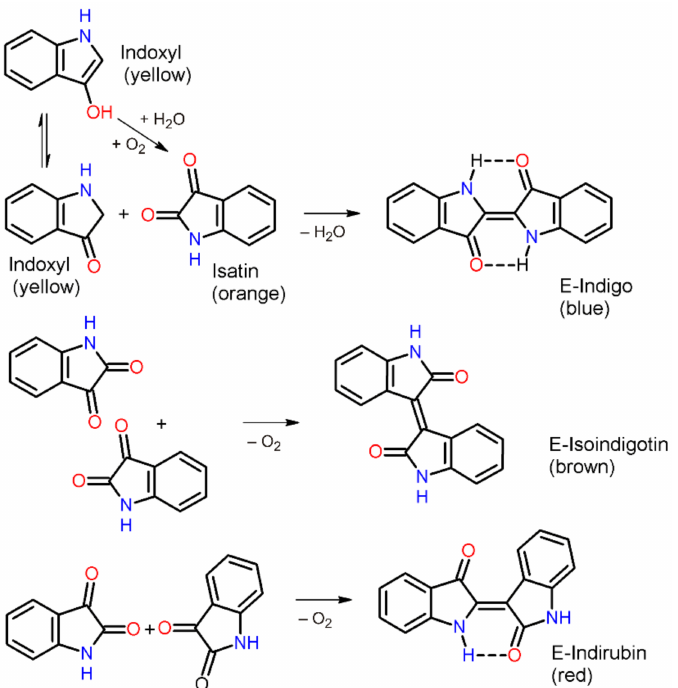
Figure 1. Synthesis of E-indigo, E-isoindigotin and E-indirubin from isatin and indoxyl. Two in- tramolecular hydrogen bonds can be formed only in the case of the isomer